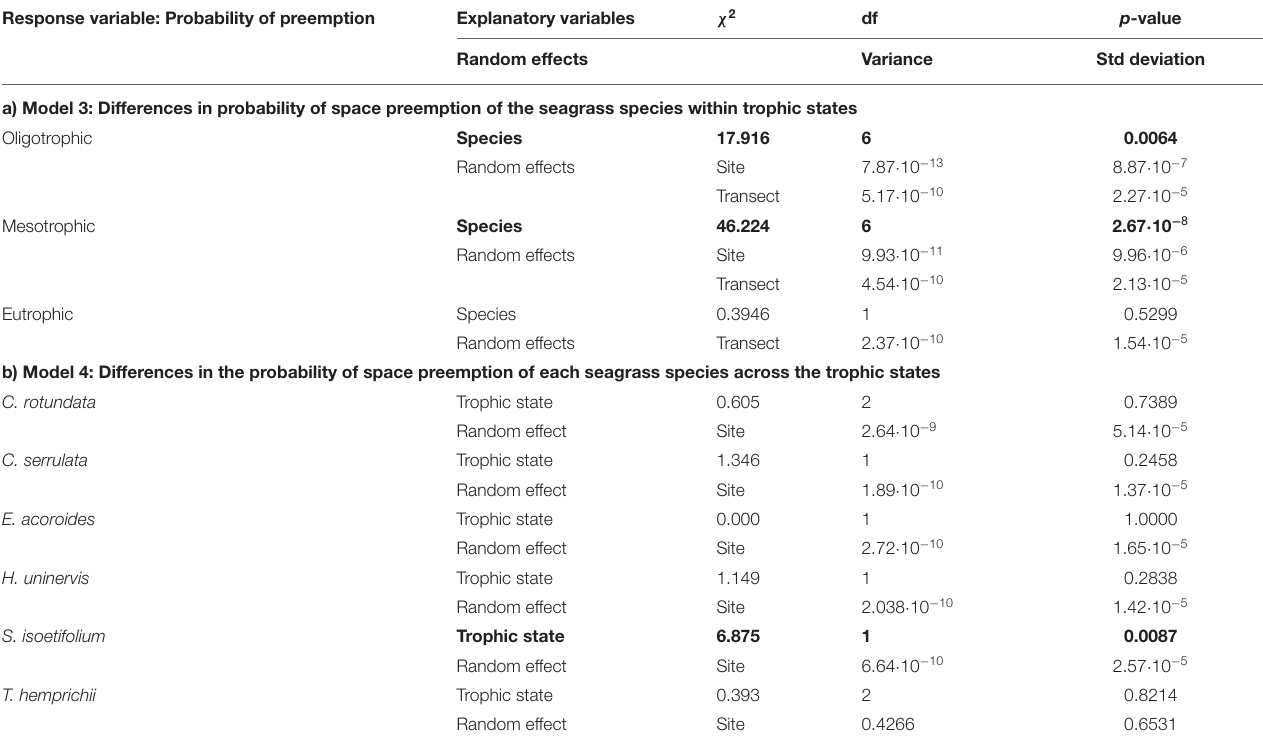
TABLE 3 | Complete output of models assessing (a) Model 3: Differences in probability of space preemption of the seagrass species within trophic states and (b) Model 4: Differences in the probability of space preemption of each seagrass species across trophic states. Response variable: Probability of